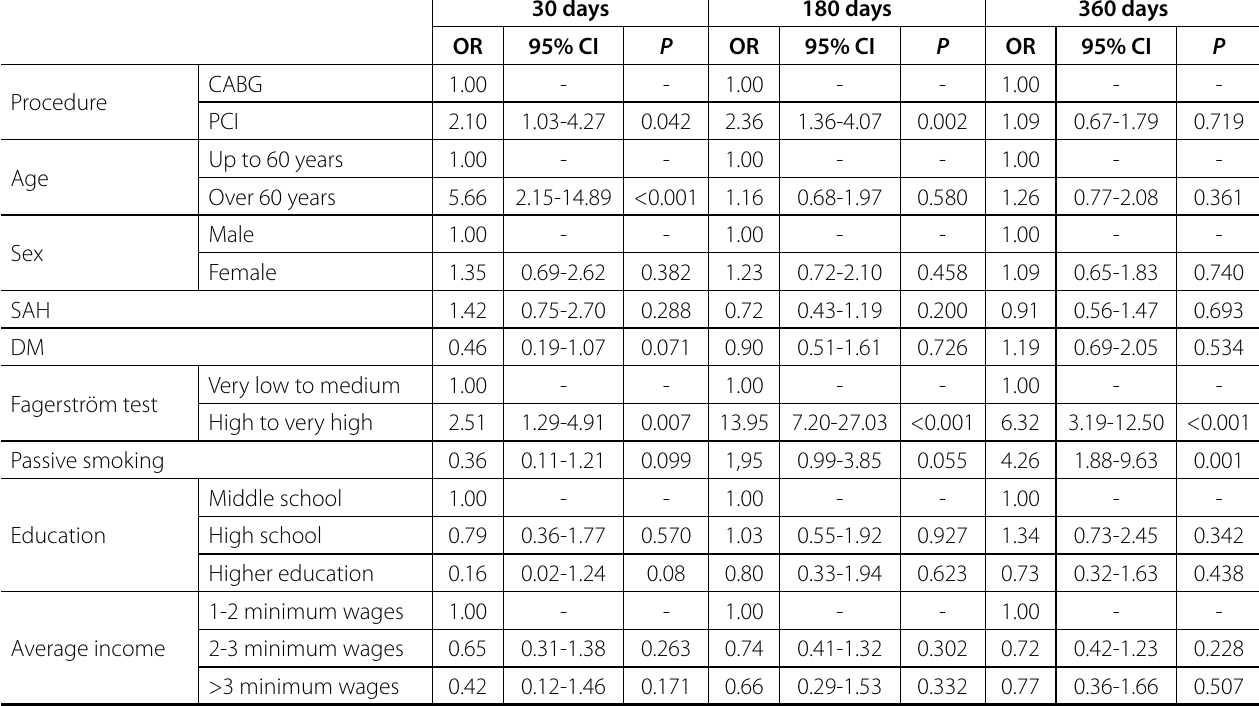
Table 3. Univariate logistic regression